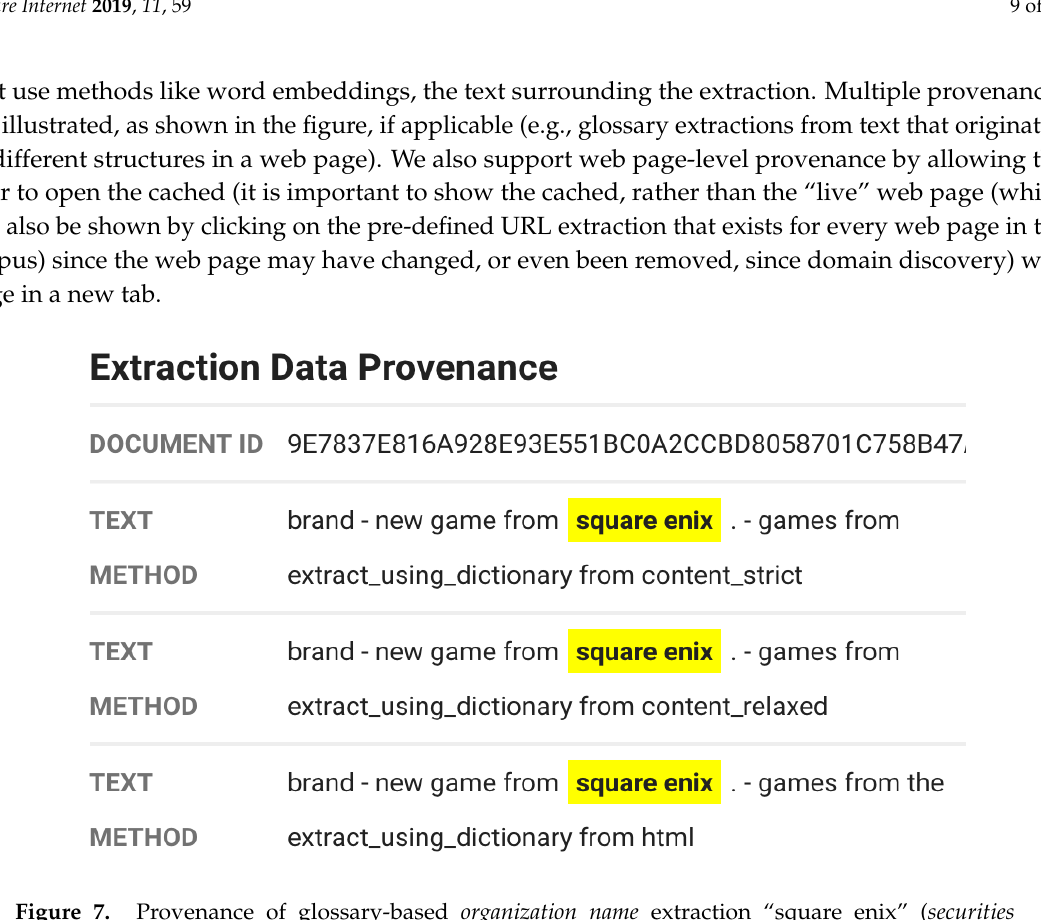
Figure 7. Provenance of glossary-based organization name extraction “square enix” ( securities fraud